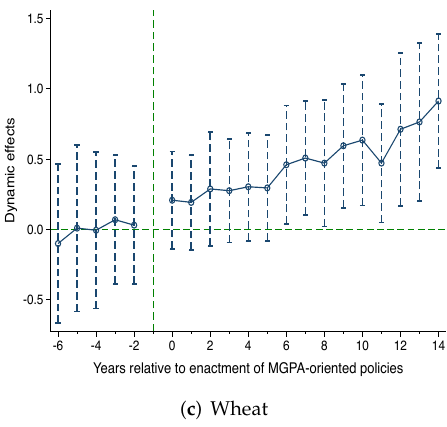
Figure 3. Tests for parallel trends.